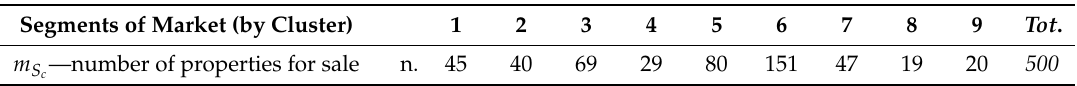
Table 5. Distribution of the sample of properties for sale in nine clusters. Segments of Market (by